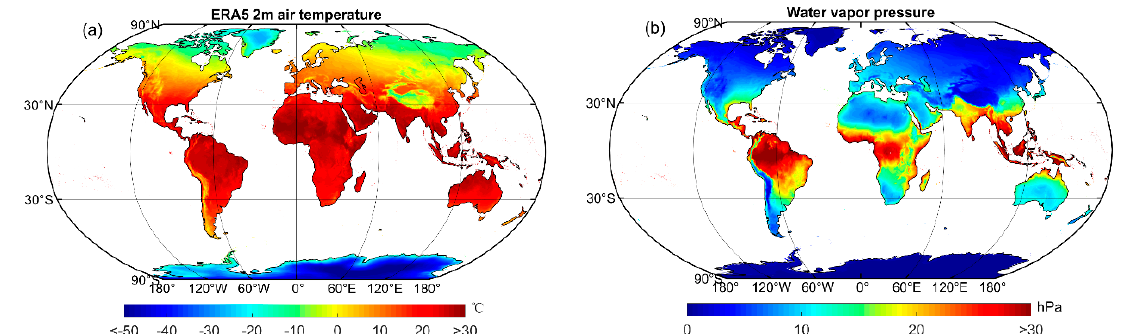
Figure 12. The spatial distribution of annual mean values for the ( a ) ERA5 2-m air temperature and ( b ) water vapor pres- sure from 2003 to 2018.